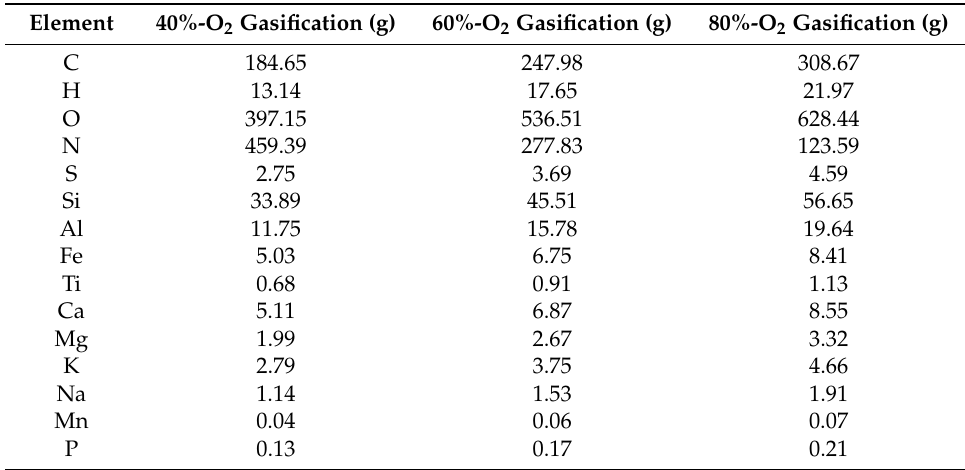
Table 4. Input into